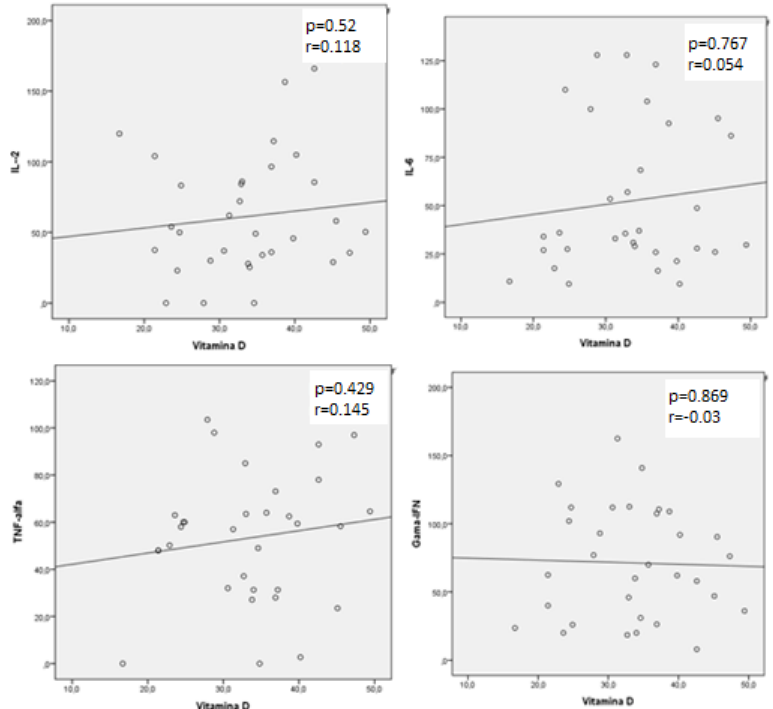
Figure 3. Correlation between serum levels of vitamin D and pro-inflammatory cytokines (IL-2, IL-6, TNF- α and IFN- γ ) in HTLV-asymptomatic carriers.